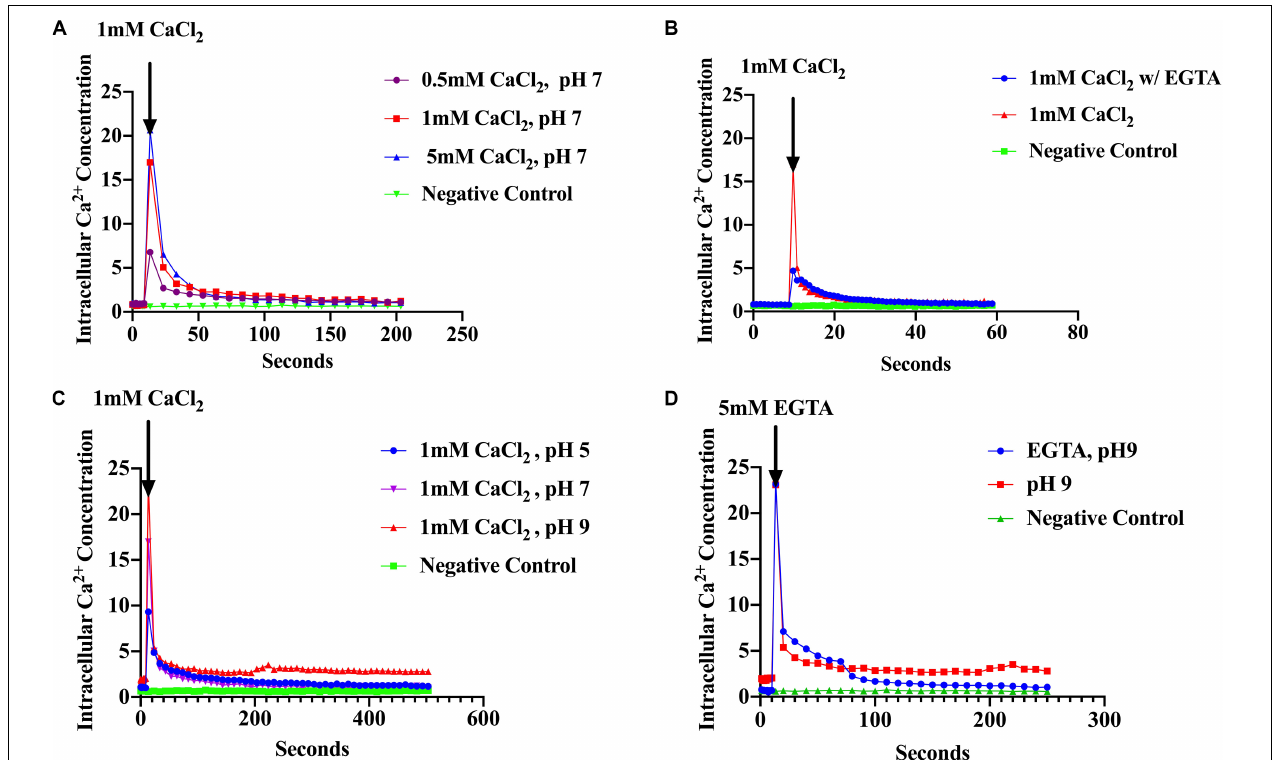
FIGURE 1 | S. aureus cells maintain Ca 2 + homeostasis. (A) Cytosolic Ca 2 + transient in response to various CaCl 2 concentrations: 0.5, 1.0, and 5.0 mM (B) Cytosolic Ca 2 + transients after addition of 1 mM CaCl 2 and the Ca 2 + chelator EGTA (C) Cytosolic Ca 2 + transients in response to different pH 5, 7, and 9 (D) Cytosolic Ca 2 + transients at pH 9 and addition of EGTA. S. aureus cells without aequorin were used as the negative controls. The results represent the means of three independent measurements. Significant peak differences were observed in response to pH as well as Ca 2 + levels. A student t was conducted to evaluate treatments ( p < 0.0001).